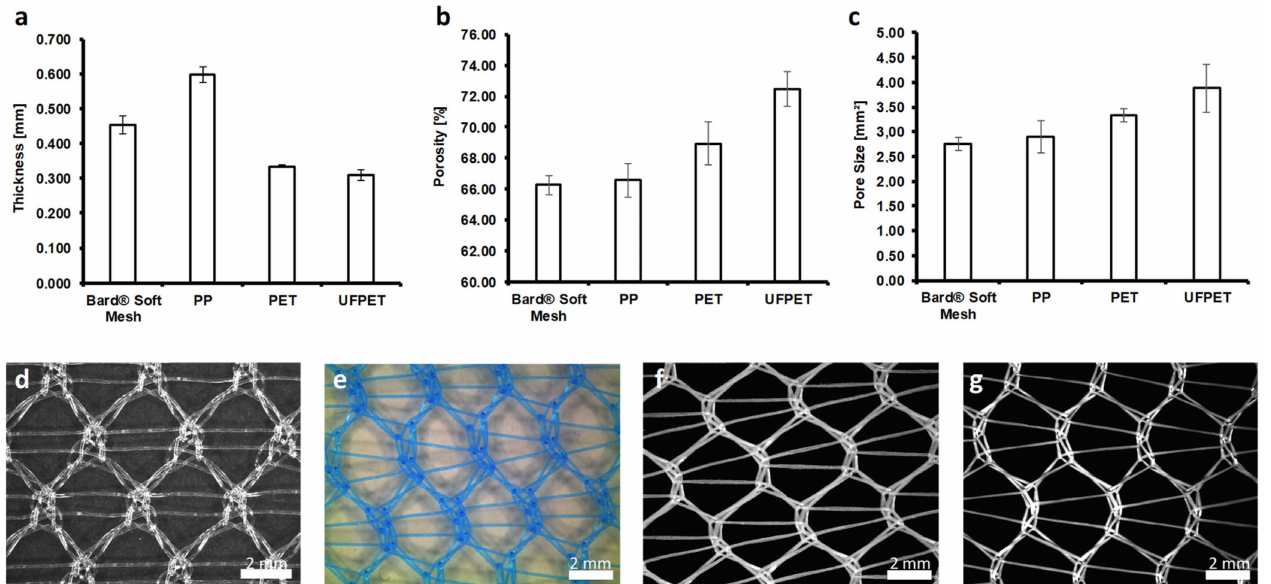
Figure 3. Morphological characterization and light microscopic images of the different mesh config- urations: ( a ) thickness, ( b ) porosity, ( c ) pore size, ( d ) Bard ® Soft Mesh, ( e ) PP monofilament mesh, ( f ) PET multifilament mesh, and ( g ) UFPET multifilament mesh.